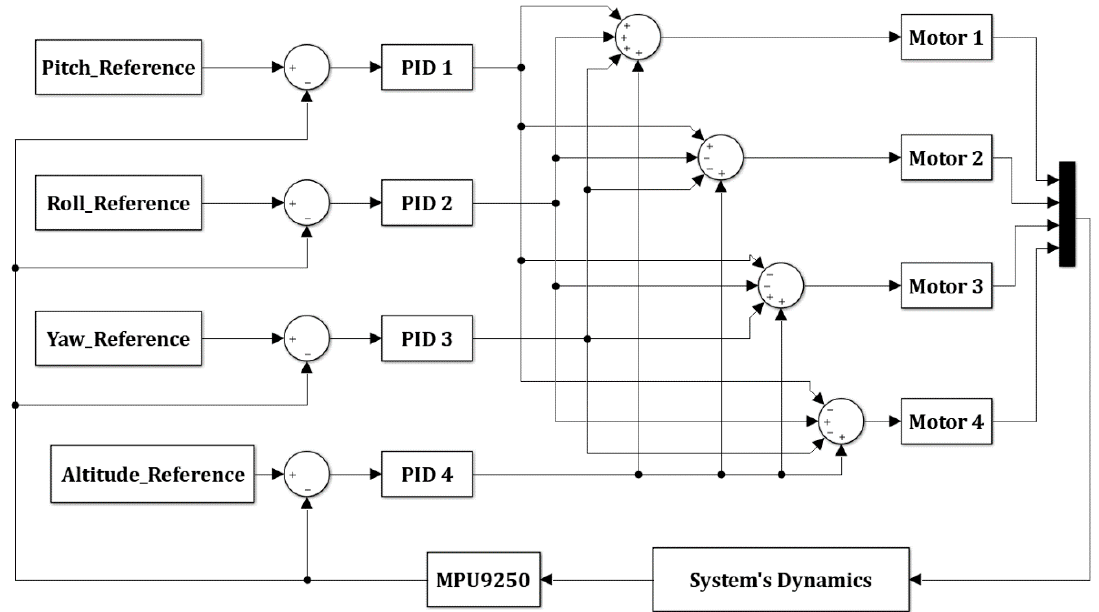
Figure 1. Block diagram of the three-dimensional space orientation control.